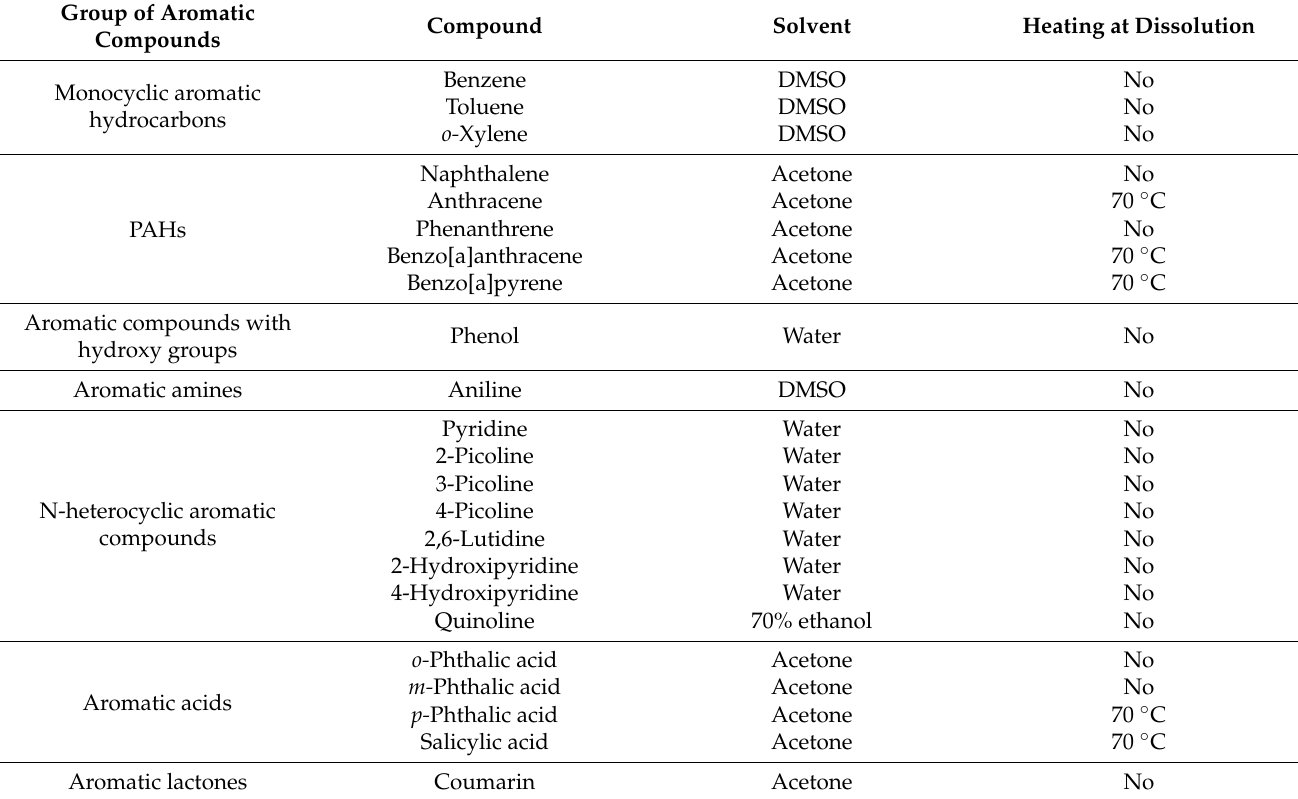
Table 5. Aromatic compounds used as growth substrates for Rhodococcus cells and conditions for their